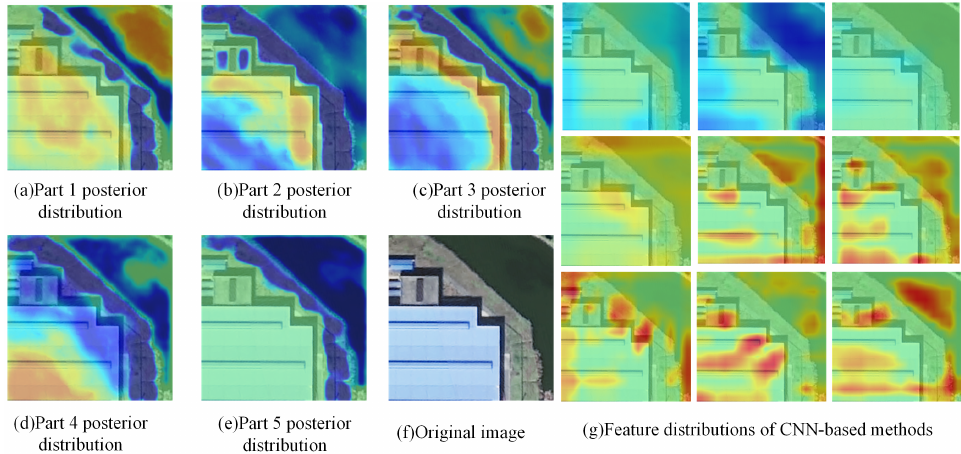
Figure 7. Visualization of the posterior building parts